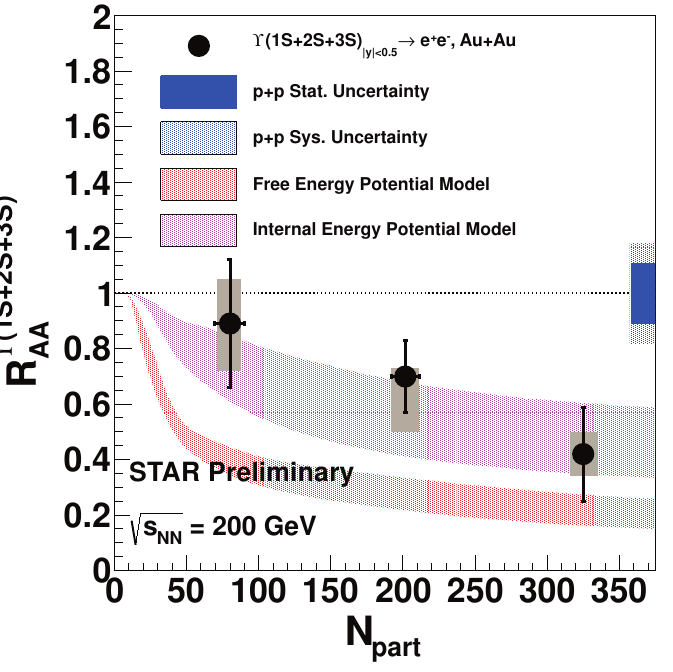
Figure 5. The nuclear modification factor of Υ (1S,2S,3S) production as a function of the number of participants in 200 GeV Au + Au collisions measured by the STAR experiment. Taken from Ref.